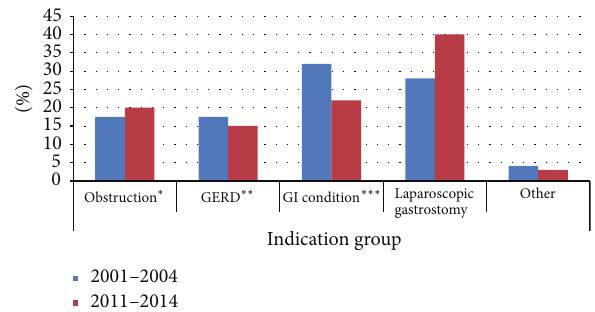
Figure 5: Percentage distribution of indications from January 2001 to December 2004 (455 patients) compared to July 2011 to May 2014 (376 patients). ∗ Obstruction in the upper gastrointestinal tract, ∗∗ gastroesophageal reflux disease, and ∗∗∗ investigation of gastroen- terological